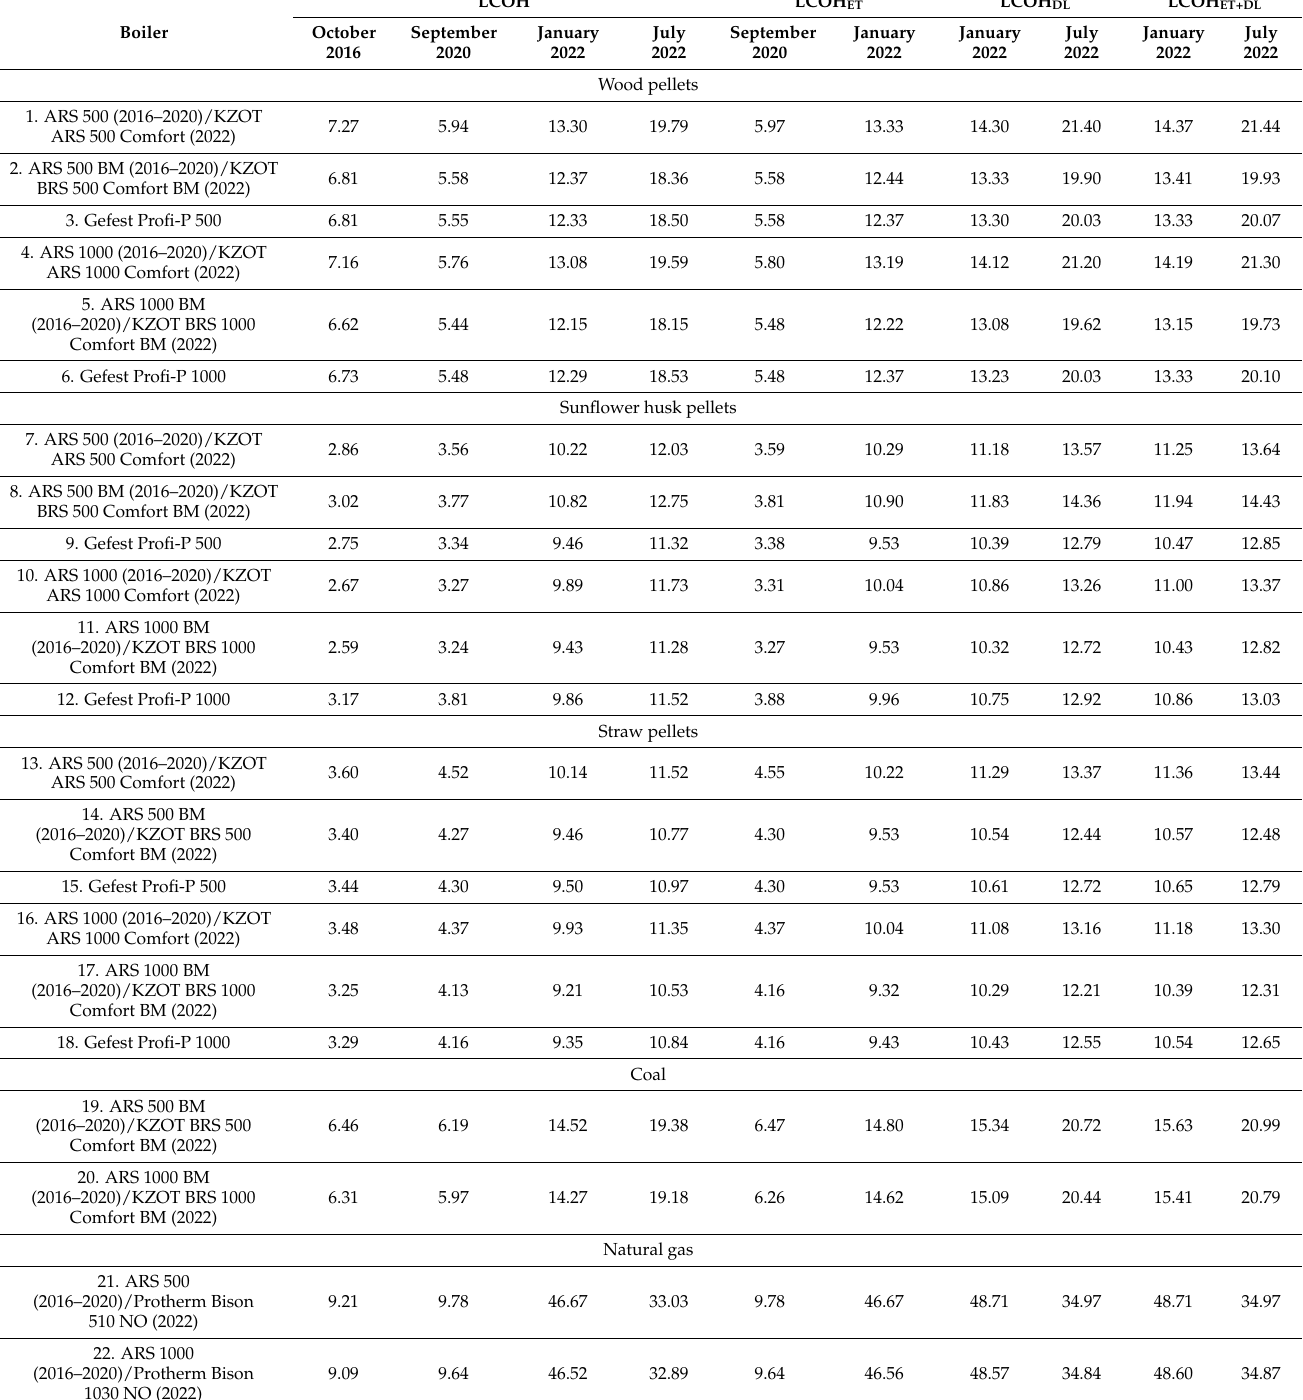
Table 4. LCOH and its components in 2016, 2020, and 2022,